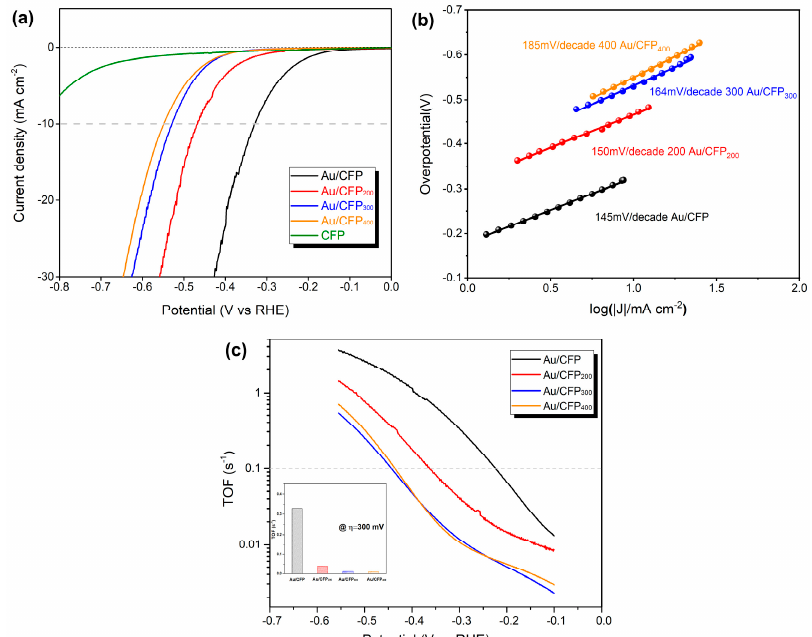
Figure 6. Effect of GBs on Au surface on the electrochemical HER activity of Au/CFP electrodes. ( a , b ) Electrochemically active (EA) surface area − calibrated linear sweep voltammetry (LSV) curves and Tafel plots for four Au/CFP electrodes with a size of 0.5 × 1 cm 2 (electrolyte: 0.5 M H 2 SO 4 , scan rate: 5 mVs − 1 ). ( c ) Turnover frequency per surface Au atom of various Au/CFP samples, and the inset is the TOF value obtained at an overpotential of 300 mV.